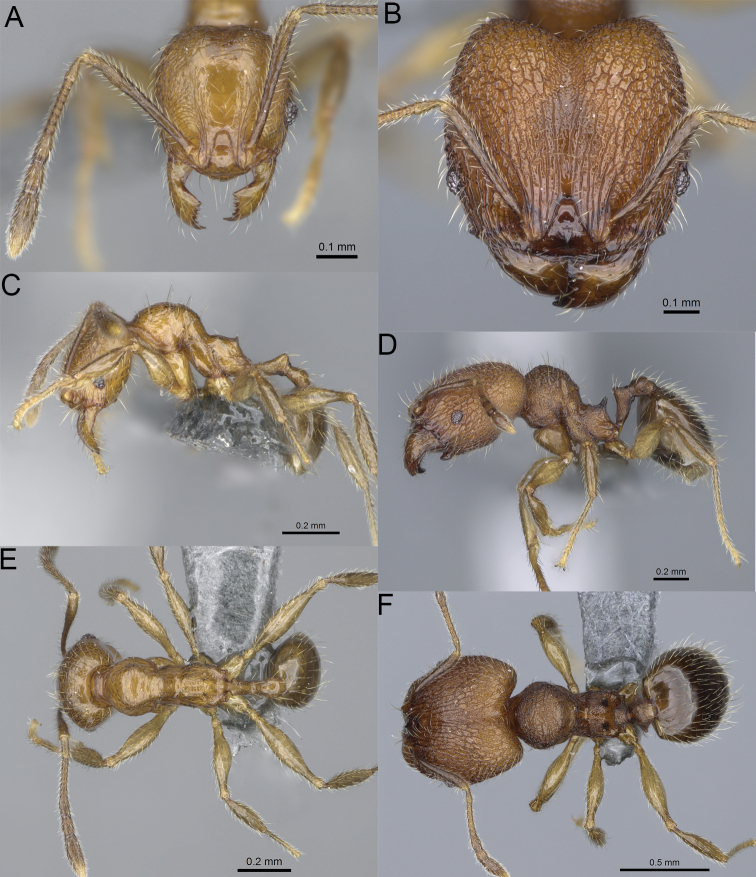
Pheidole
parvula sp. nov., full-face view (A), profile (C), and dorsal view (E) of paratype minor worker (CASENT0923270) and full-face view (B), profile (D), and dorsal view (F) of holotype major worker (CASENT0274865).